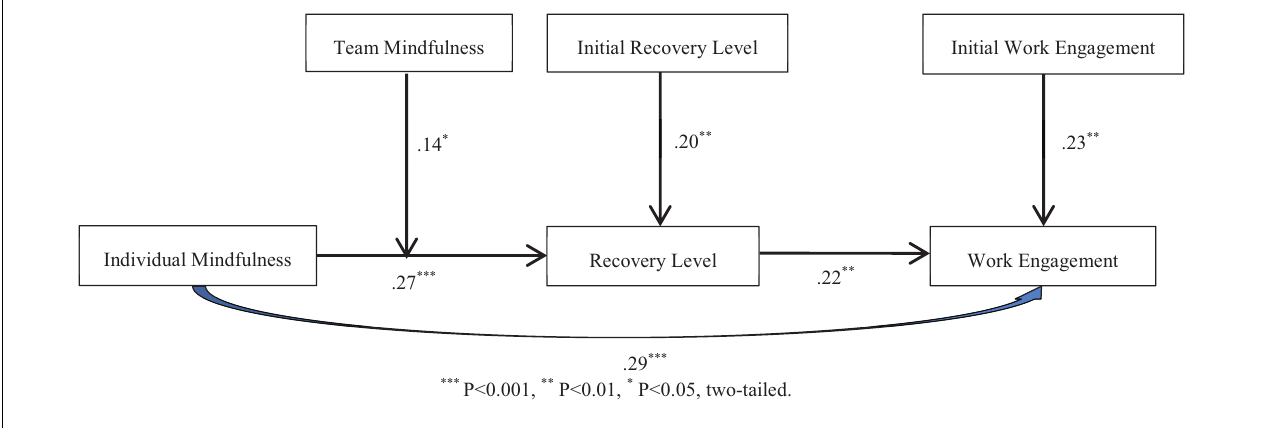
FIGURE 1 | MSEM results for the theoretical model.